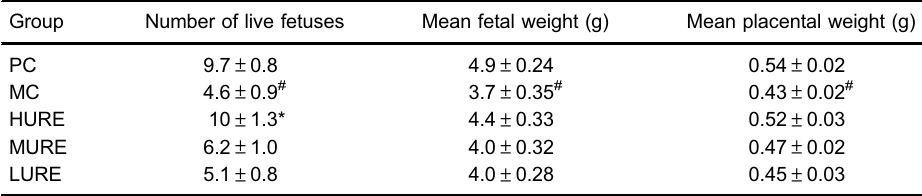
Data are reported as means ± SE (n=8/group). # P o 0.05 vs the PC group, *P o 0.05 vs the MC group